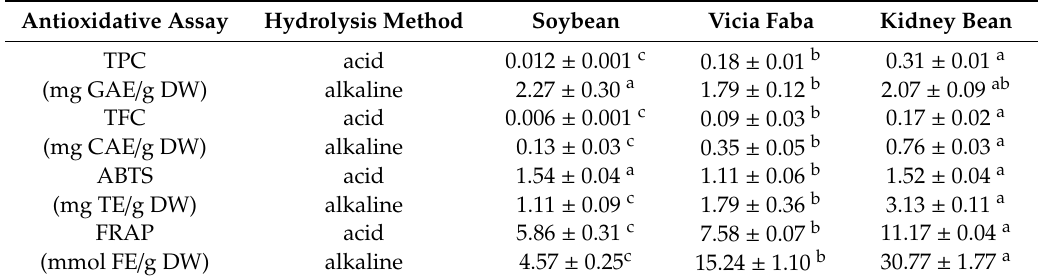
Table 1. Total phenolic contents, total flavonoids content, and antioxidant activities of bound phenolics in legumes. A